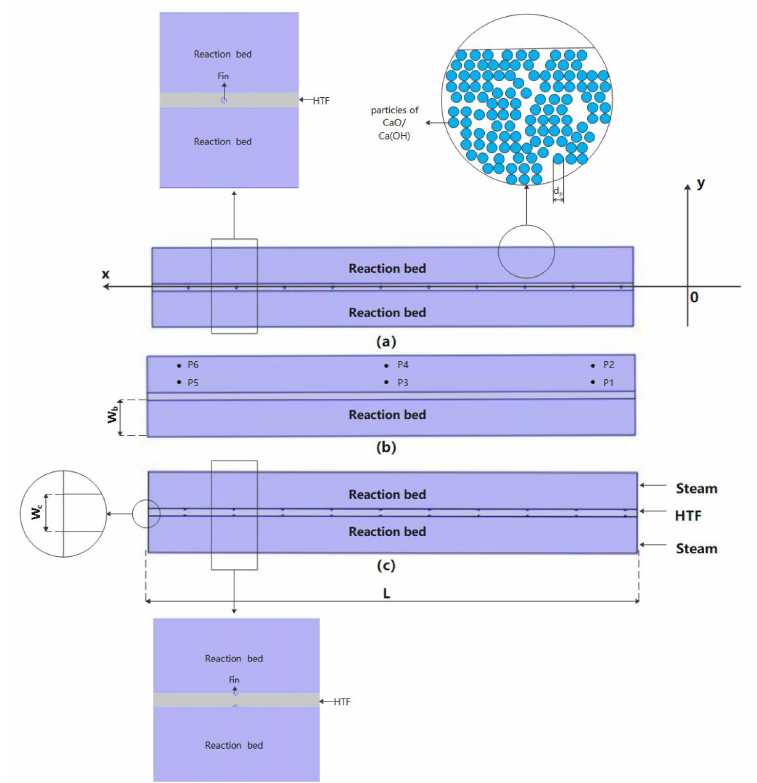
Figure 3. Two-dimensional models of three kinds of heat exchange structures for TCES reactors. ( a )